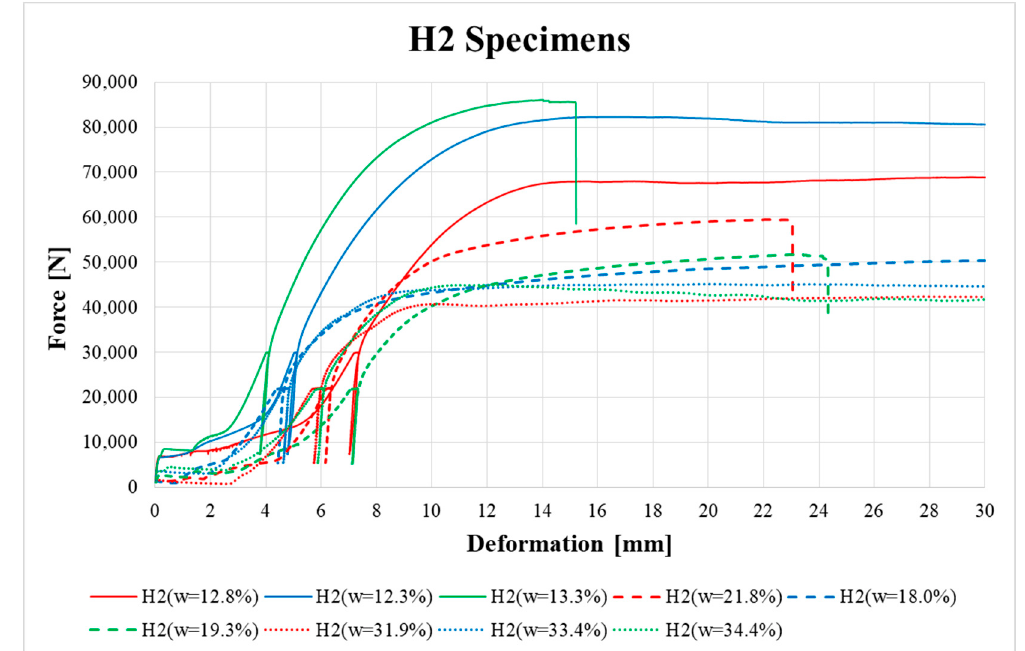
Figure 9. Load–deformation curves of H1 specimens.